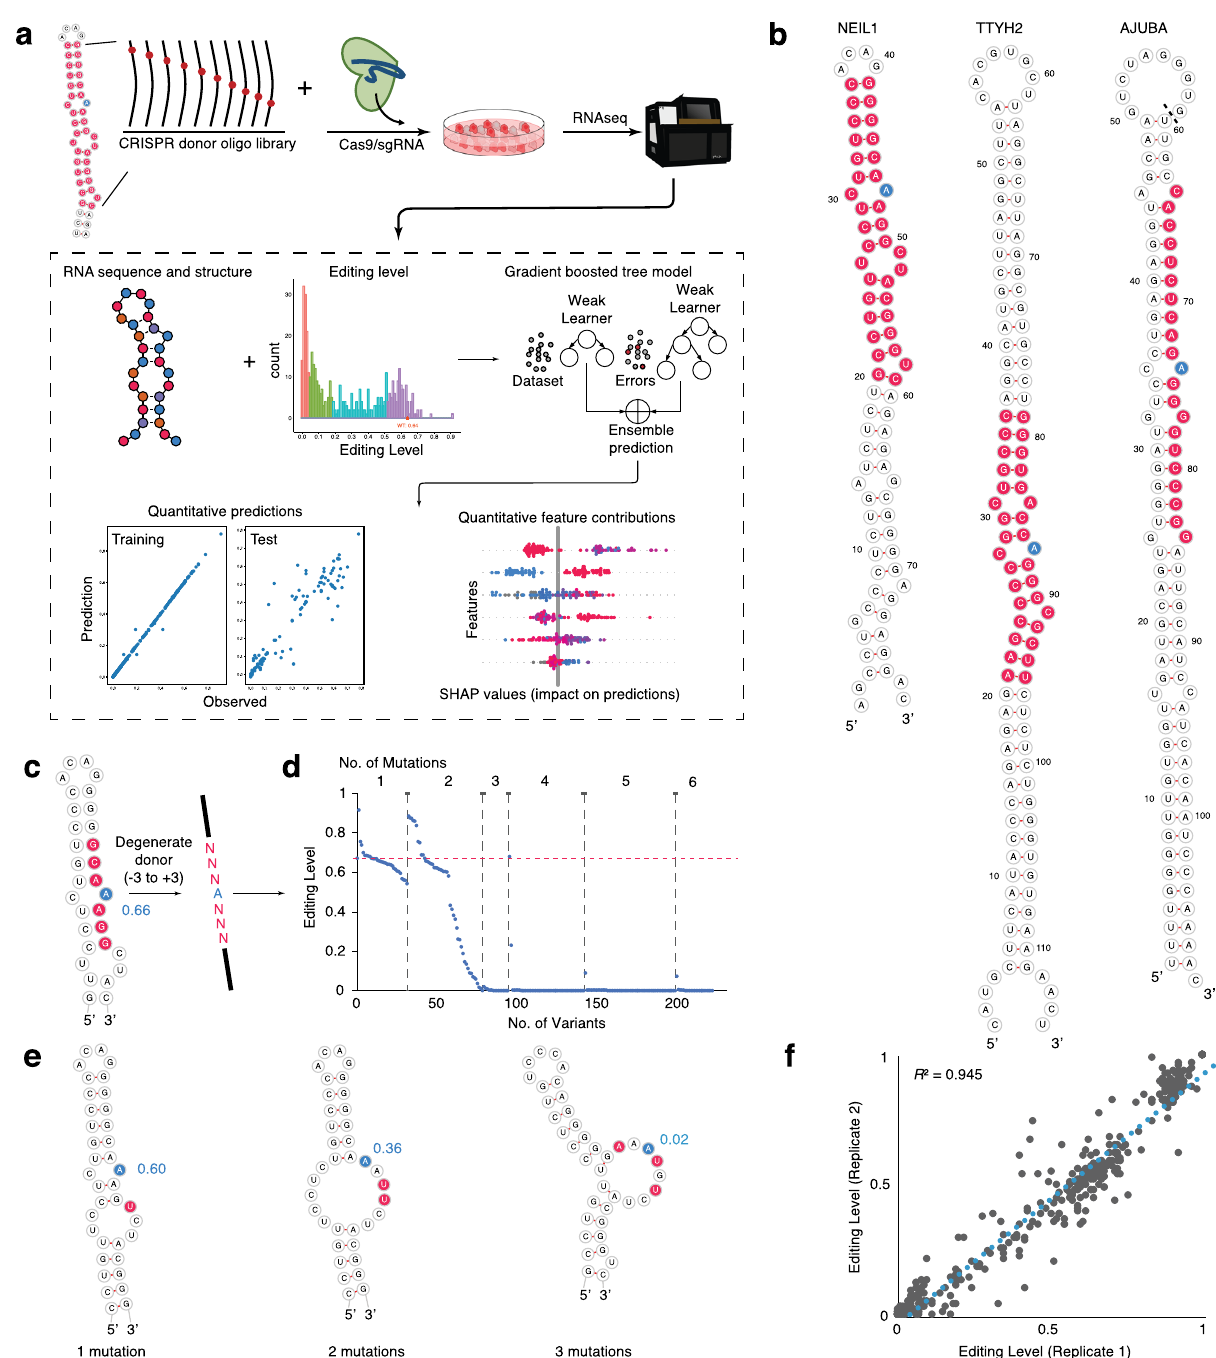
Fig. 1 CRISPR/Cas9-mediated mutagenesis in endogenous RNA to dissect RNA editing by ADAR1 in cells. a Overview of the experimental methods and computational pipeline. CRISPR/Cas9-mediated homology-directed repair is applied to mutagenesis of endogenous RNA in HEK293T cells. A supervised machine learning method (a gradient boosted tree, XGBoost) was applied to develop quantitative models that predict how cis -elements, such as RNA sequence and secondary structure determine RNA editing level. b Sequence and secondary structure of the three RNAs, NEIL1, TTYH2, and AJUBA, for targeted mutagenesis. The residues subjected to mutations are highlighted in red and the speci fi c editing site is in blue. For AJUBA, partial sequences from the genomic sequences are taken to focus on the region of interest. Therefore, the G59 and U60 shown in b is 524 nt apart in the genomic region. c Degenerate donor oligos are designed for the − 3 to + 3 nt region around the speci fi c editing site in the NEIL1 substrate. The mutagenized region is highlighted in red and the editing site in blue. The value of editing level is shown in blue. d The distribution of editing level by the number of mutations from the results of the degenerate NEIL1 library from c . e Examples of how the number of mutations affect the RNA secondary structure of NEIL1. The mutagenized nucleotied is highlighted in red and the editing site in blue. The value of editing level is shown in blue. f Reproducible editing measurement of the two replicates of the targeted mutagenesis library of NEIL1 shown by pairwise comparison with Spearman R 2 labeled.